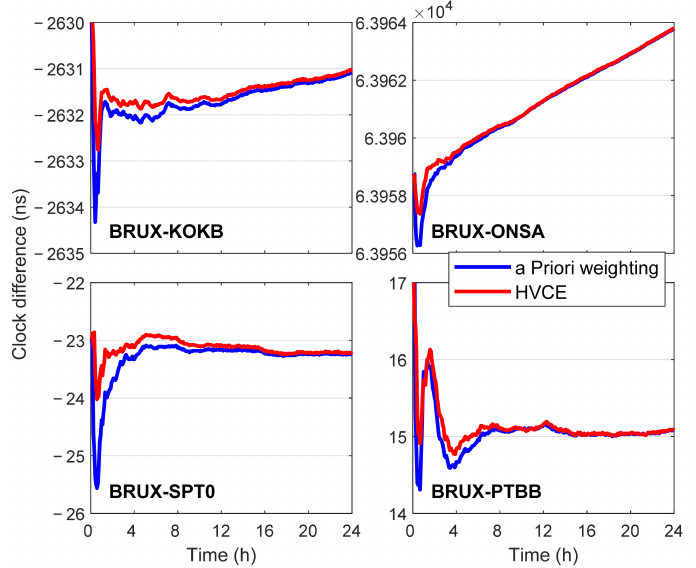
Figure 5. Four time links generated by Galileo five-frequency PPP with the a priori weighting method and HVCE method on DOY 251, 2021.